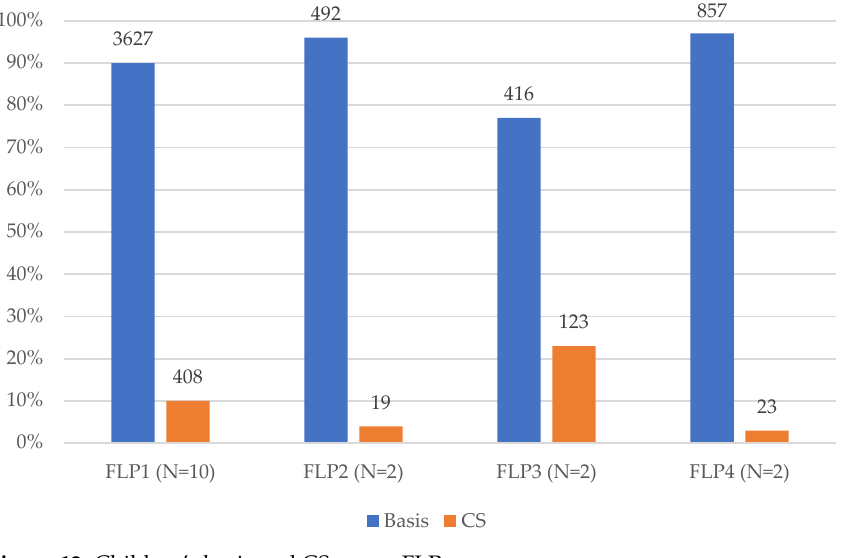
Figure 12. Children’s basis and CS across FLP.